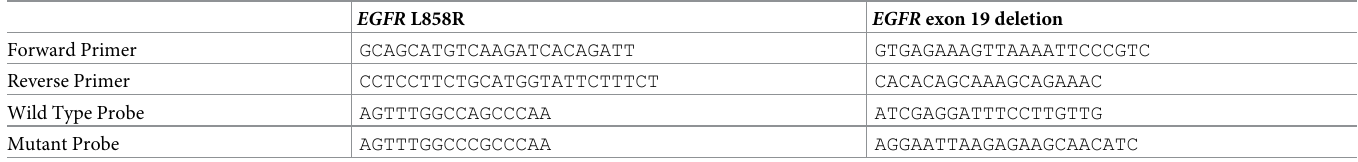
Table 1. Primer and probe sequences for EGFR mutation detection.